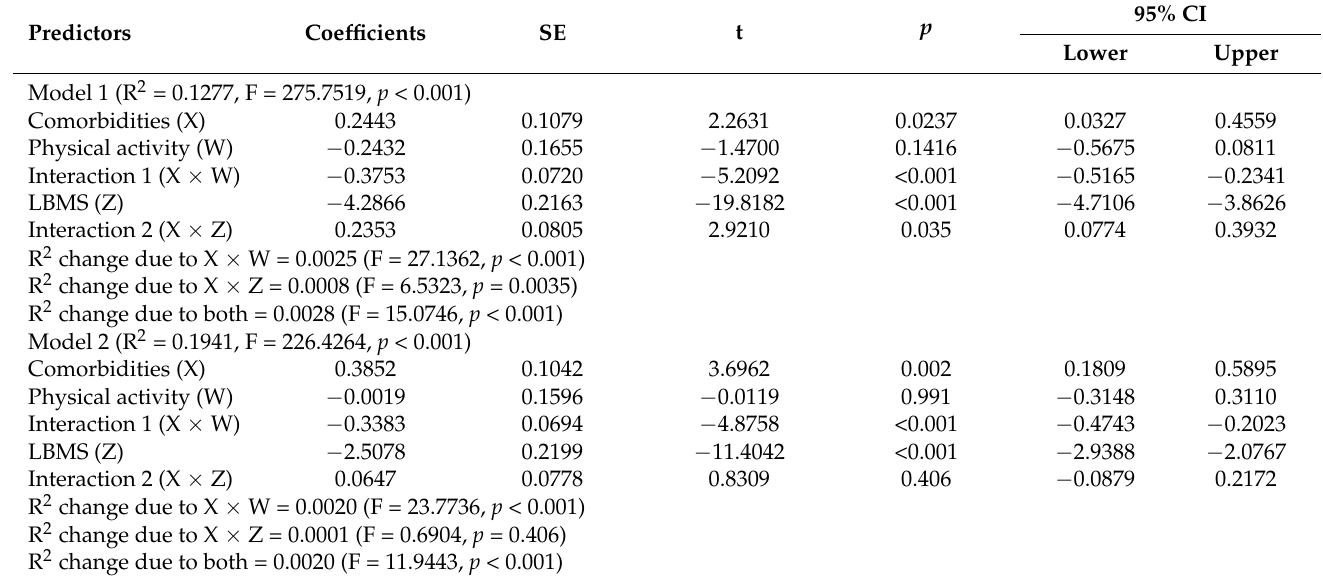
Table 4. A moderation analysis of physical activity and lower-body muscle strength on the relation- ship between comorbidity and cognitive function.